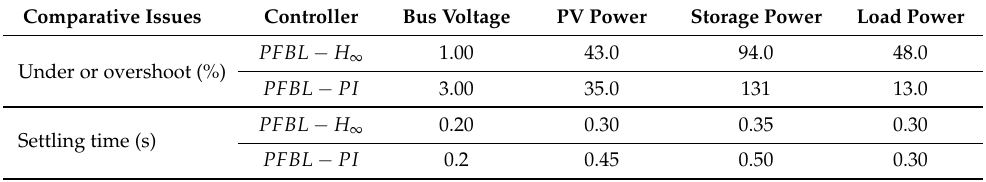
Table 5. Quantitative comparison between proposed and existing controller under measurement